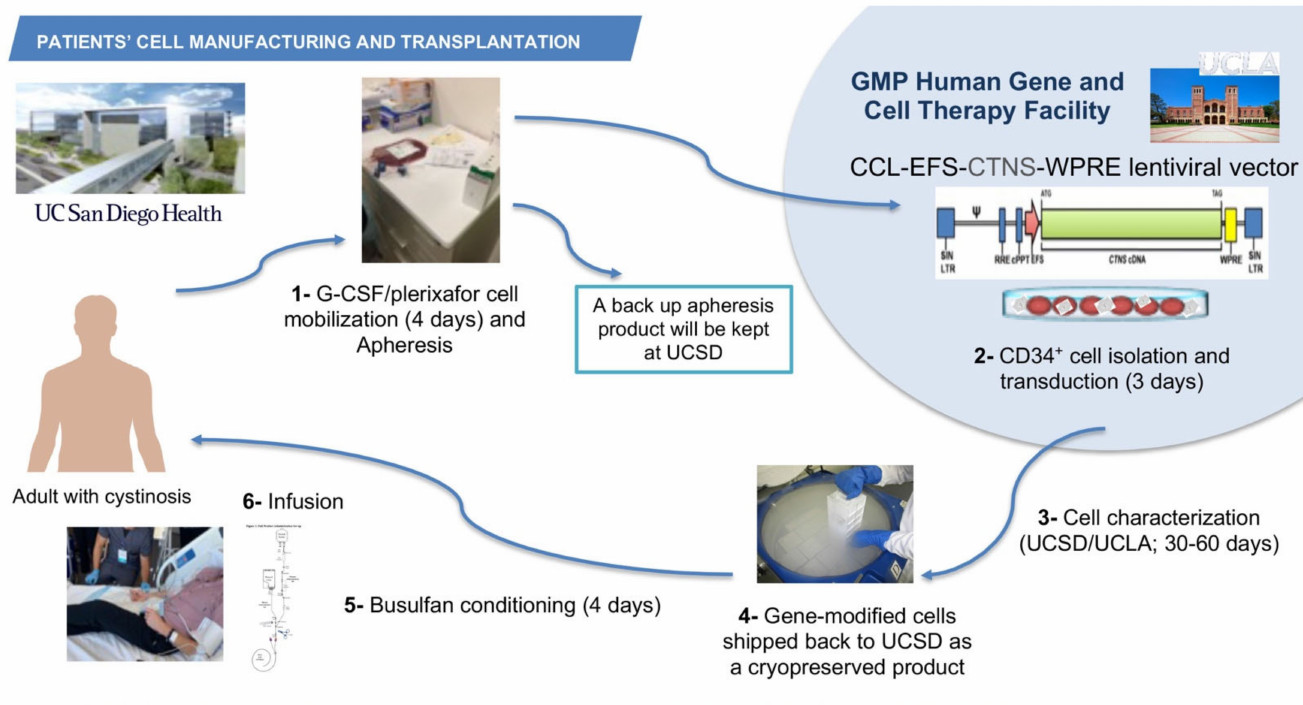
Figure 2. Manufacturing and infusion of the investigational product CTNS-RD-004. Patients with cystinosis undergo G-CSF/plerixafor stem cell mobilization in the peripheral blood, and then apheresis. One bag of apheresis is kept at UC San Diego and one bag is shipped to the HGCTF at UCLA, where the CD34 + cells are isolated and transduced with the GMP pCCL-CTNS virus preparation. The cell product is then cryopreserved and characterized. If the product meets the release criteria, it is shipped to UC San Diego where it is infused to the